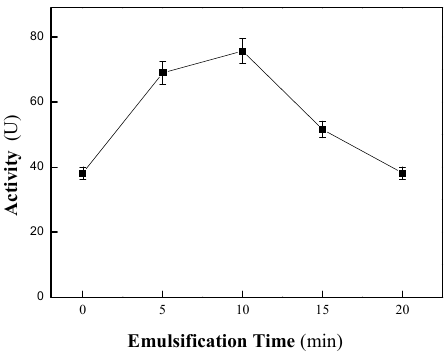
Figure 2. Effect of emulsion time on the CALB@PE activity.